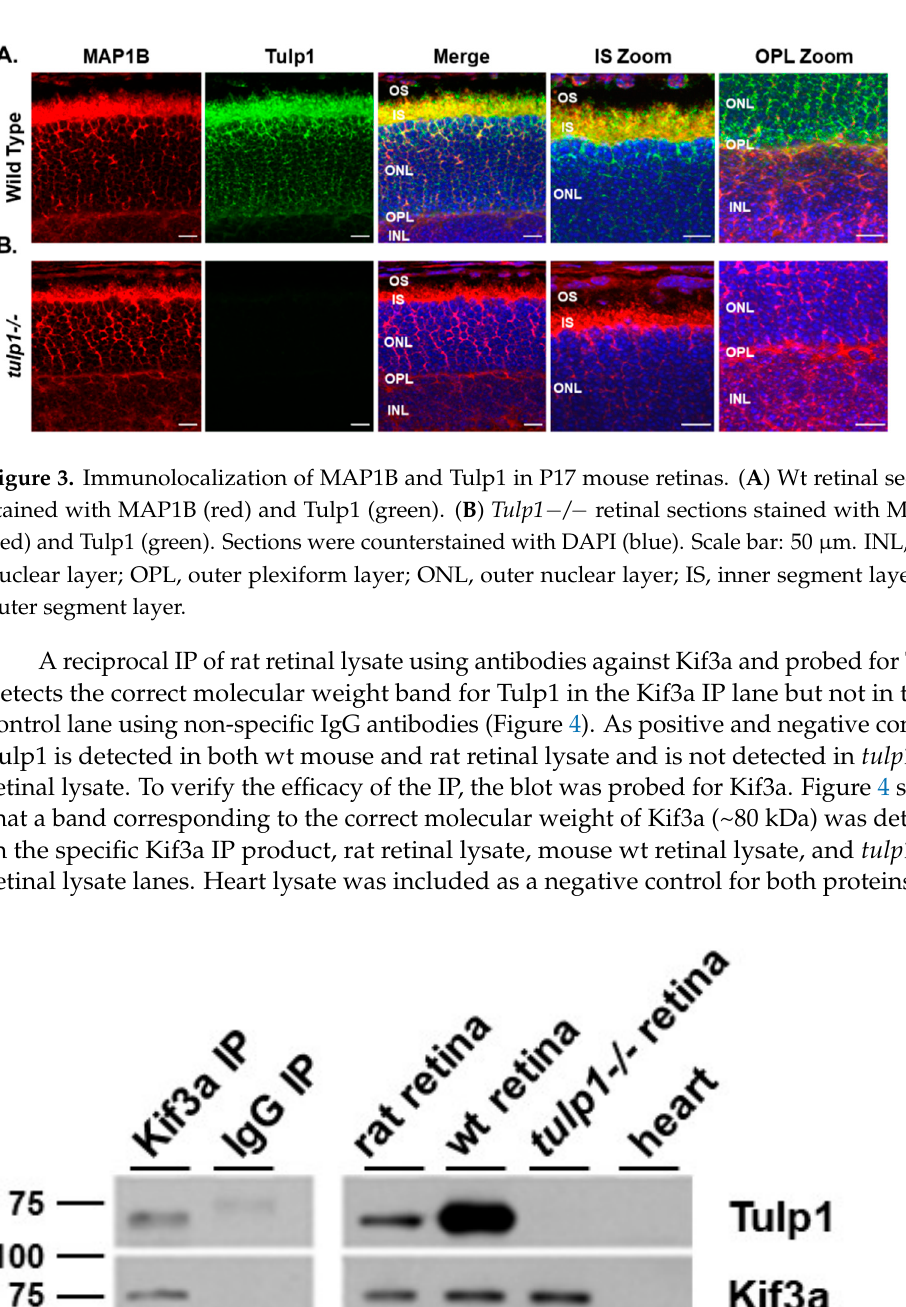
Figure 3. Immunolocalization of MAP1B and Tulp1 in P17 mouse retinas. ( A ) Wt retinal sections stained with MAP1B (red) and Tulp1 (green). ( B ) Tulp1 − / − retinal sections stained with MAP1B (red) and Tulp1 (green). Sections were counterstained with DAPI (blue). Scale bar: 50 μ m. INL, inner nuclear layer; OPL, outer plexiform layer; ONL, outer nuclear layer; IS, inner segment layer; OS, outer segment layer.